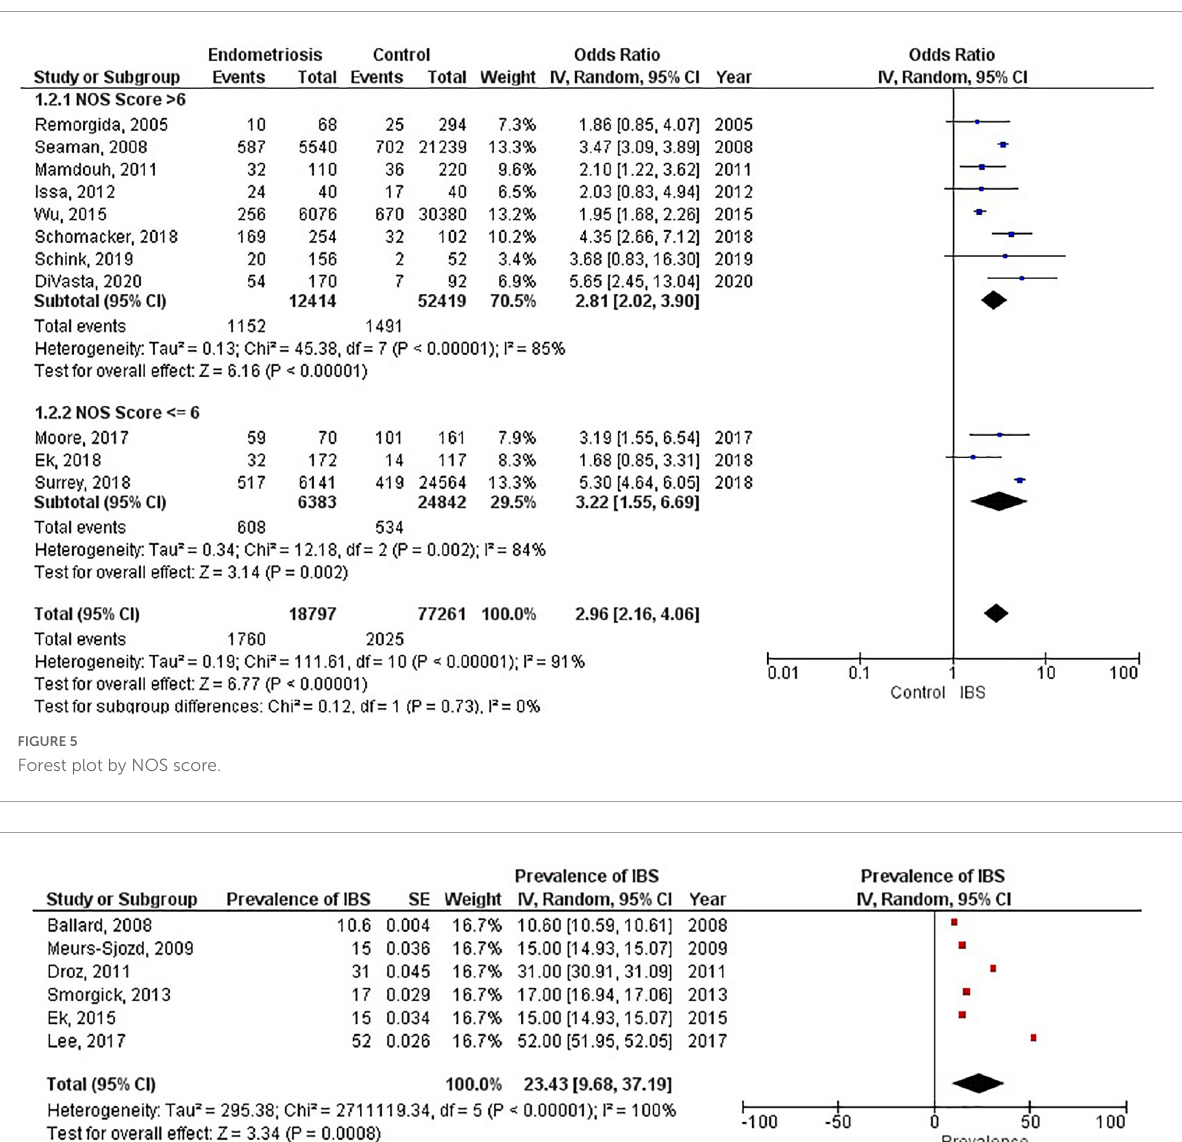
FIGURE6 Forest plot by prevalence of